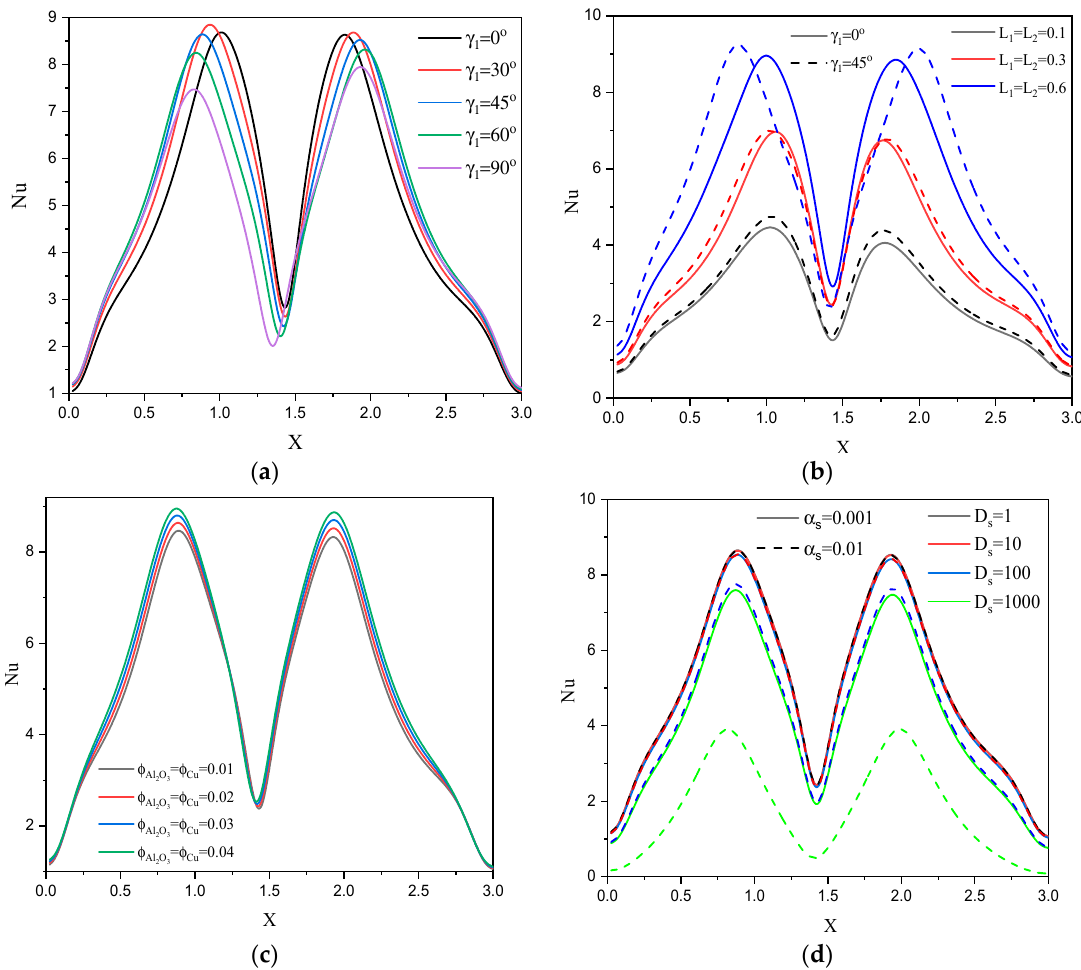
Figure 14. Local Nusselt number along X-axis under the effects of ( a ) an inclination angle, ( b ) fins lengths with two values of an inclination angle, ( c ) nanoparticle volume fraction for hybrid nanofluid, and ( d ) mixture densities ratio with two values of dusty parameter at 𝑅𝑎 = 10 (cid:2873) and 𝛾 = 0.1 .